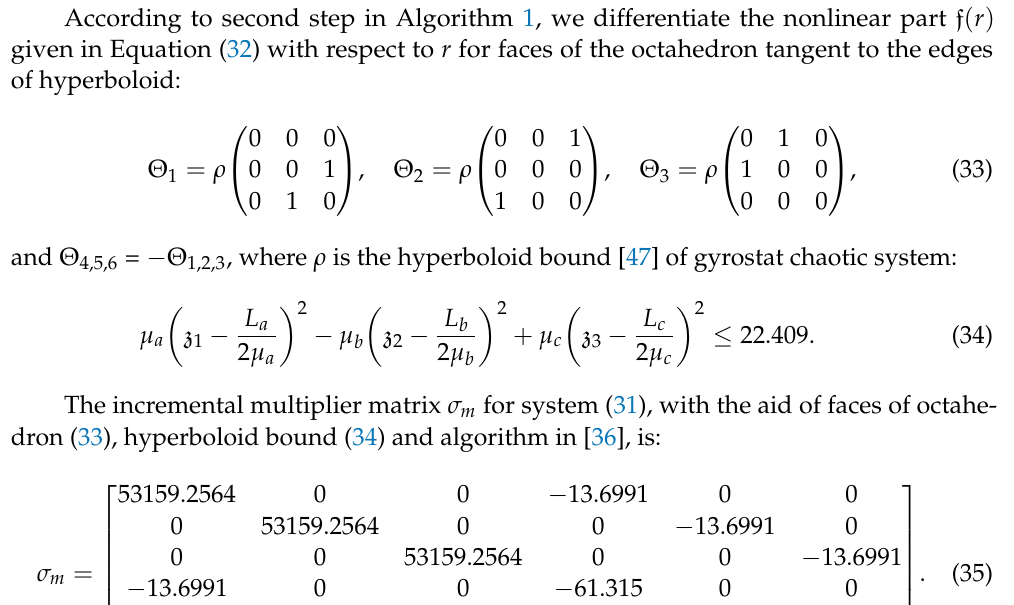
Figure 2. Three dimensional phase portraits of single to multi scrolled fractional order gyro chaotic system for β ∈ [ 0.80,0.99 ]